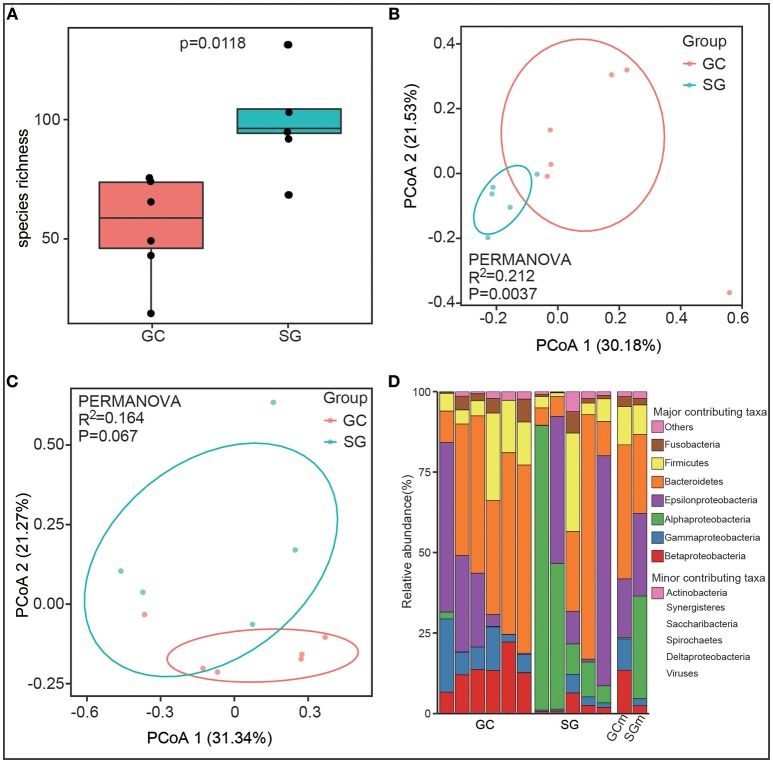
The gastric microbiota profile differs in GC and SG. (A) Species richness estimates (number of observed species), Student's t-test. Principal coordinate analysis (PCOA) plots of Jaccard index (B) and Bray-Curtis dissimilarities (C) in which samples were colored during clinical diagnosis. The percentage of diversity captured by each coordinate is shown. (D) Phyla distribution of the taxa in all samples. Proteobacteria was replaced by 5 class (alpha, beta, delta, epsilon, gamma). Biological replicates (6 replicates for GC and 5 replicates for SG samples) are displayed in separate stacked bars. The mean relative abundance of each phyla in each group is also shown in separate stacked bars. Major contributing phyla are shown in distinct colors and minor contributing taxa are grouped and displayed in pink. GC, advanced gastric adenocarcinoma; SG, superficial gastritis; GCm and SGm, the mean relative abundance of taxa in each group; PERMANOVA, non-parametric permutational multivariate analysis of variance.